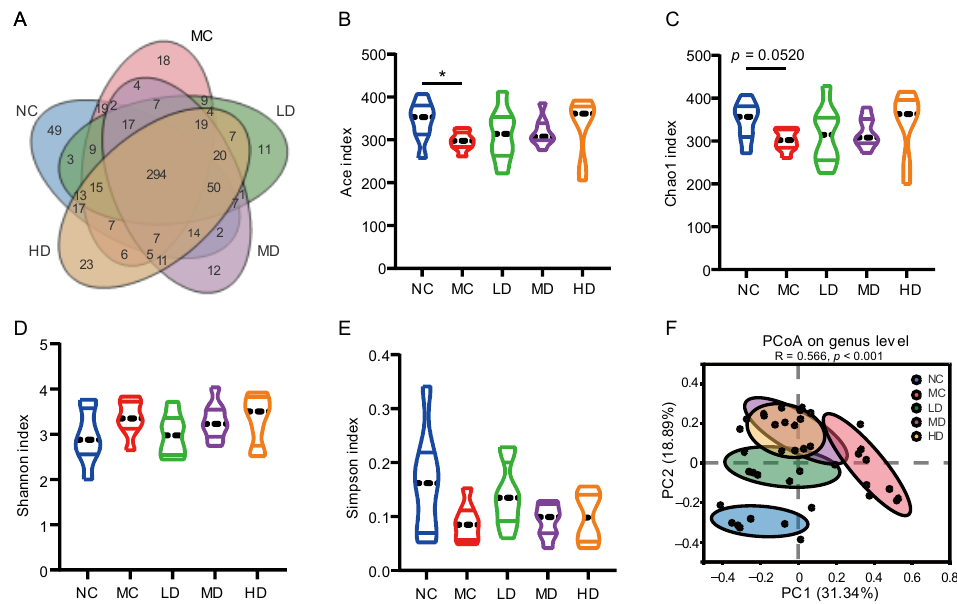
Figure 3. Effect of PHB on the diversity of the fecal microbiome. ( A ) A Venn diagram showing the overlap of the OTUs in the fecal microbiome. ( B – E ) Changes in Ace ( B ), Chao 1 ( C ), Shannon ( D ), and Simpson ( E ) alpha diversity index. ( F ) Principal coordinates analysis (PCoA) based on the Bray Curtis distance of fecal microbiota. Significance was determined using Wilcoxon rank-sum test; * p < 0.05 ( n = 8).